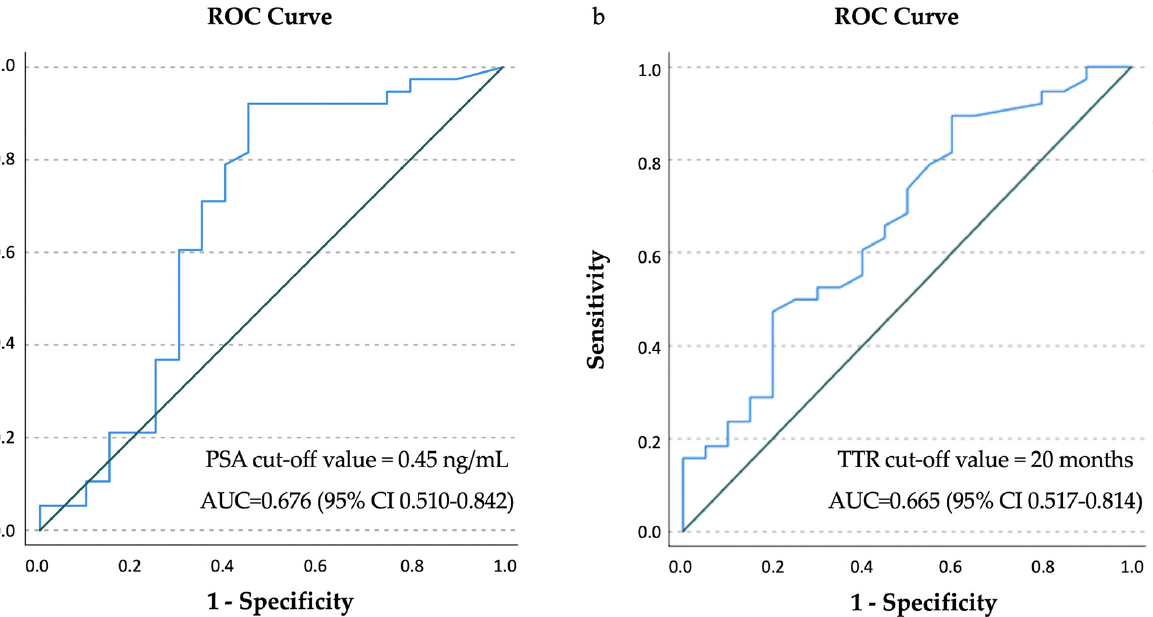
Table 2. Diagnostic performance of [ 18 F]Fluciclovine PET/CT. [ 18 F]Fluciclovine PET/CT Diagnostic Performance Value